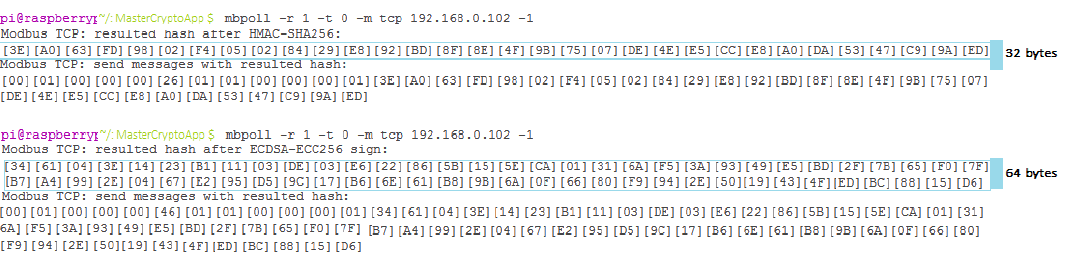
Table 4. Measurements of the executed TPM functions related to the ECDSA based proposed concept.